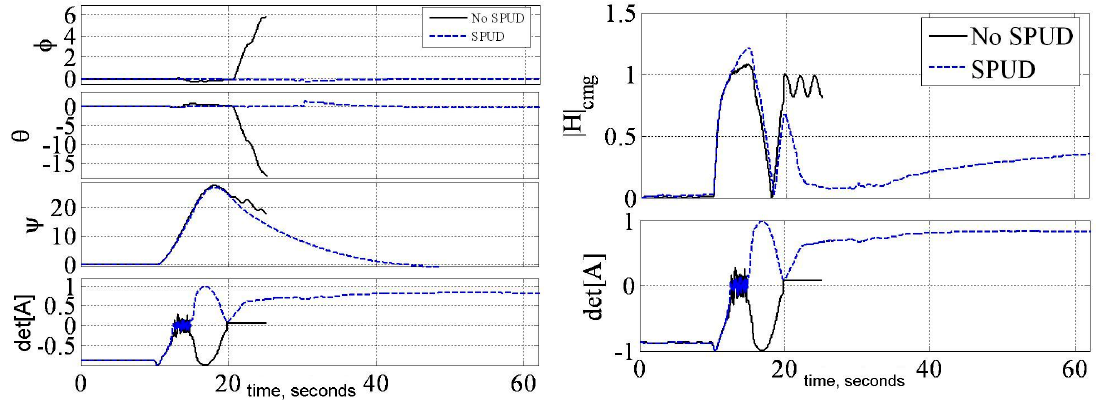
Figure 12. EXPERIMENTATION: Direct comparison of SPUD to nominal control methods. Mathematics 2018 , 6 , 1 FOR PEER REVIEW